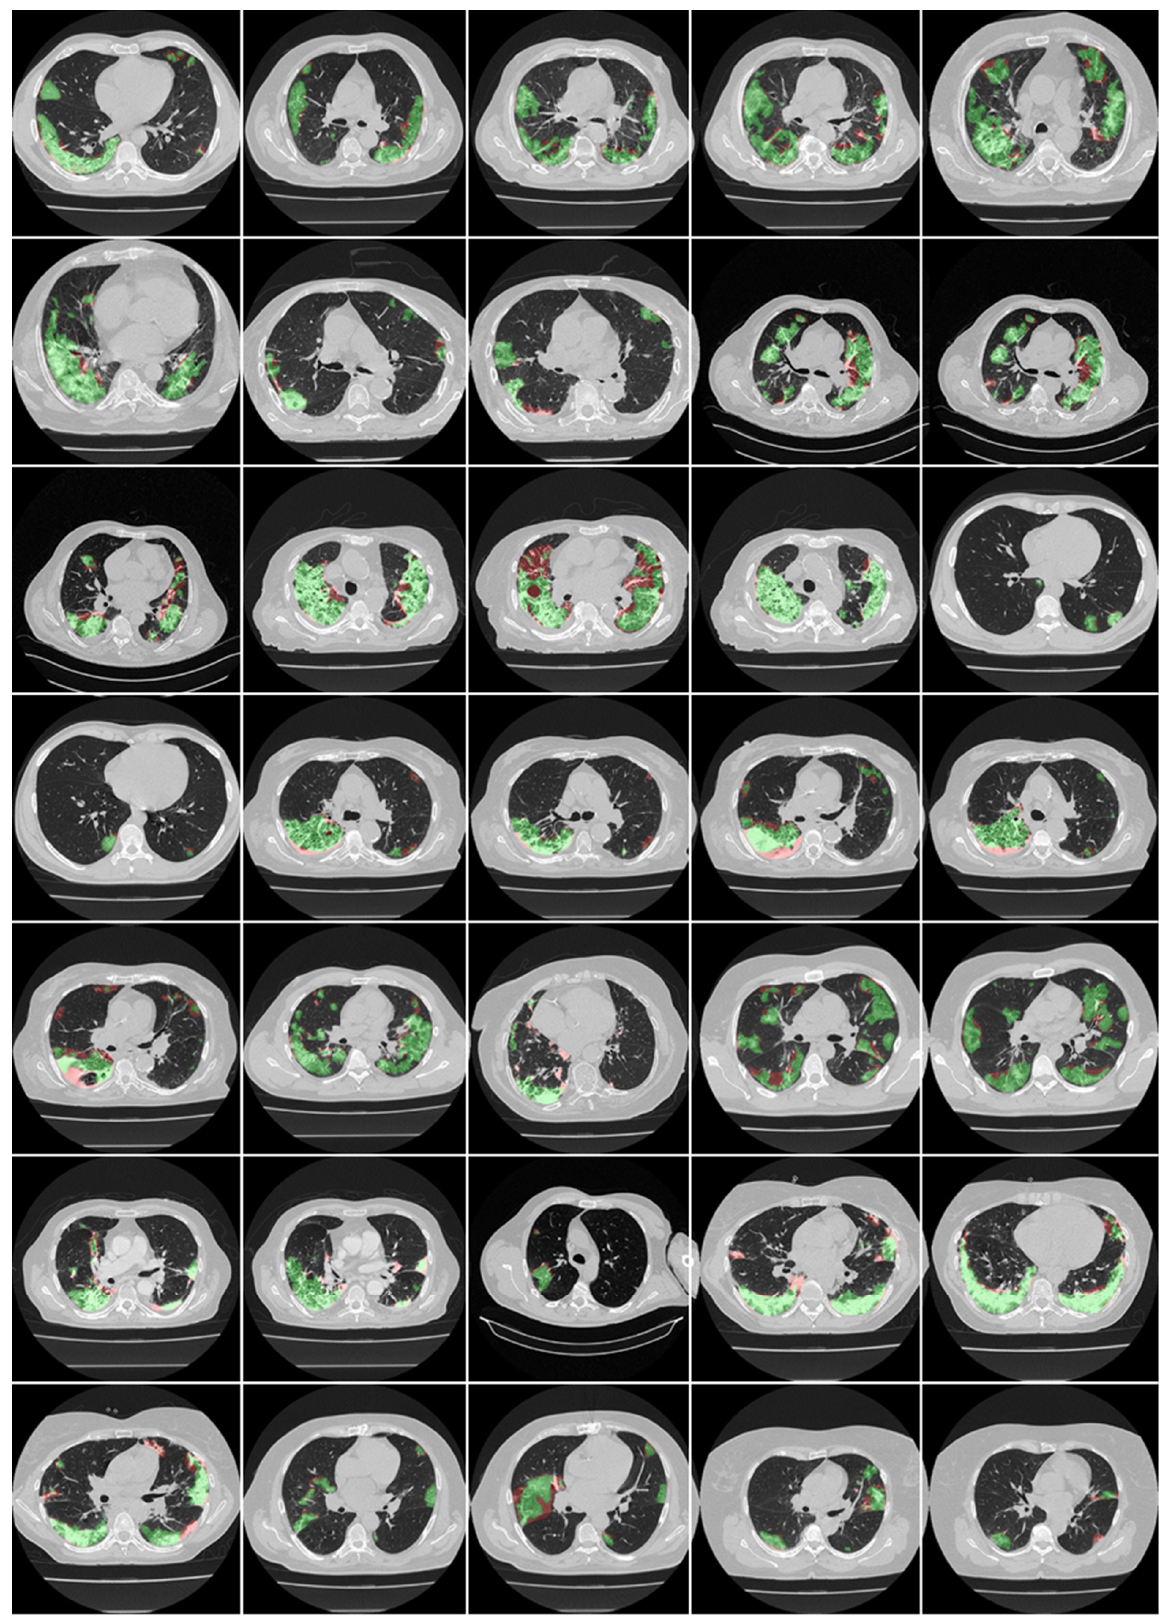
Figure A5. Results of visual lesion overlays showing ResNet ‐ UNet (green) vs. MD 1 (red).